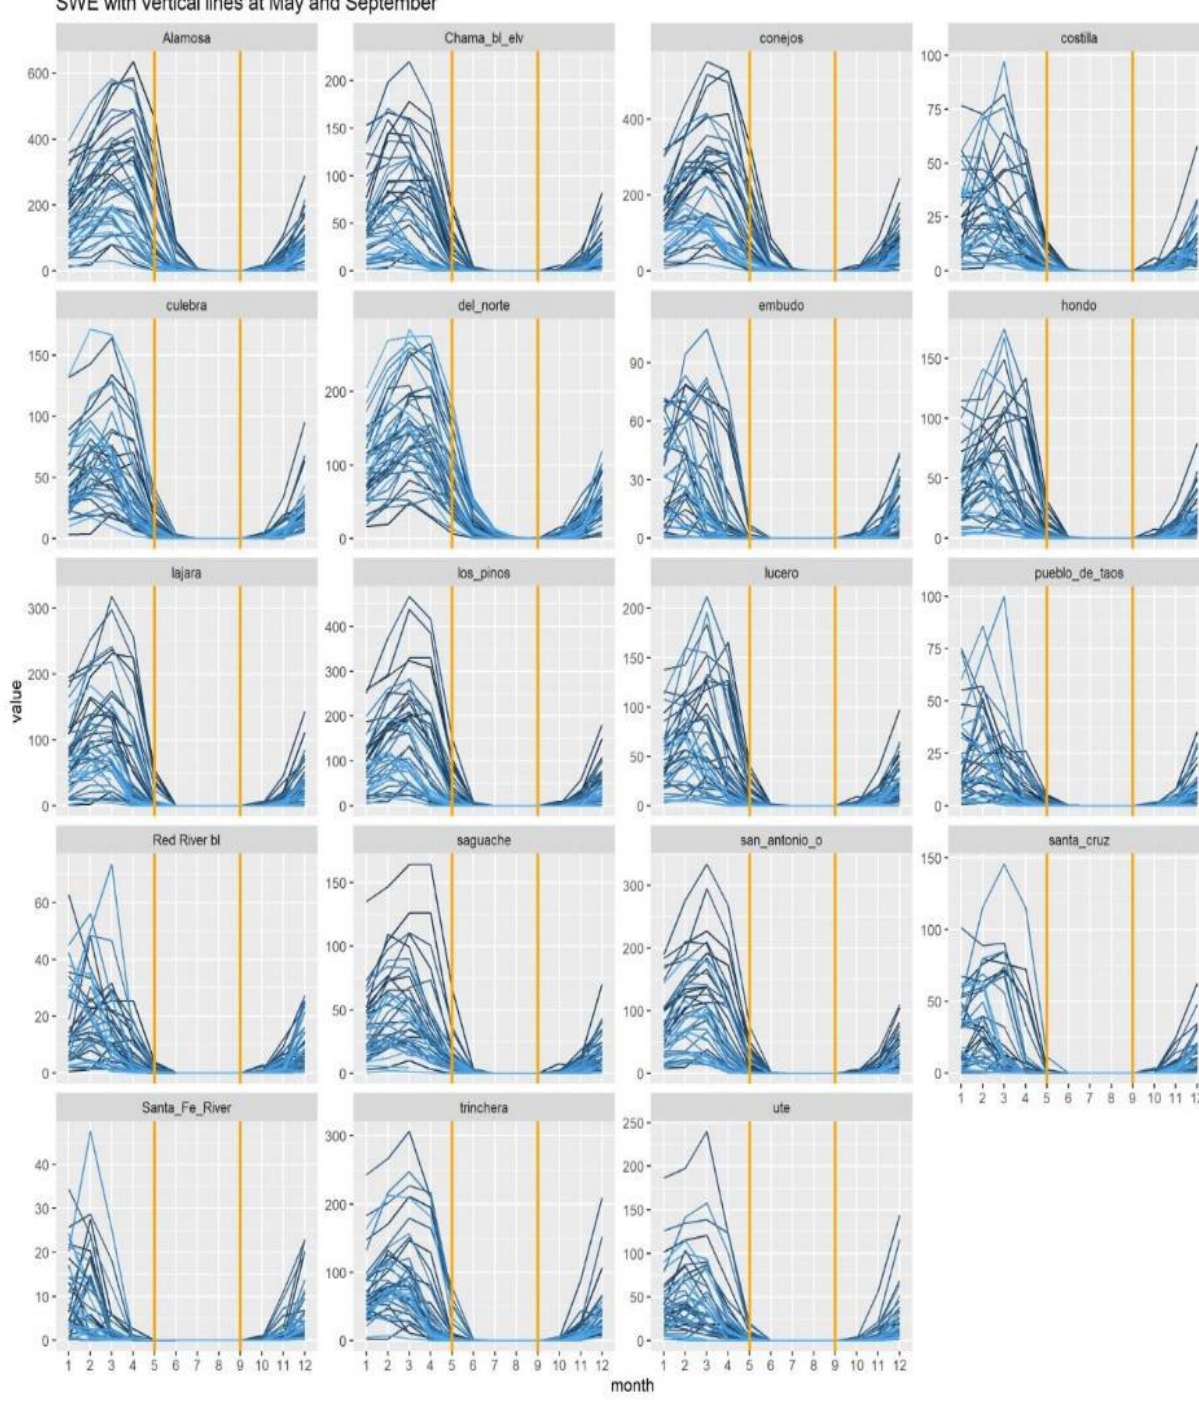
Figure A2. SWE in summer months.